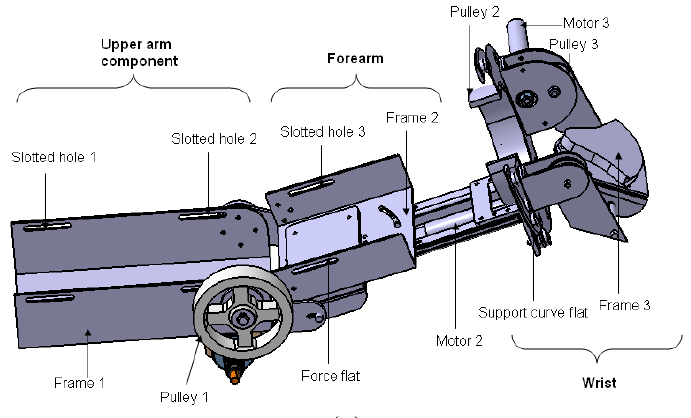
Figure 1. ( a ) The upper view of the ULERD ( b ) The lower view of the